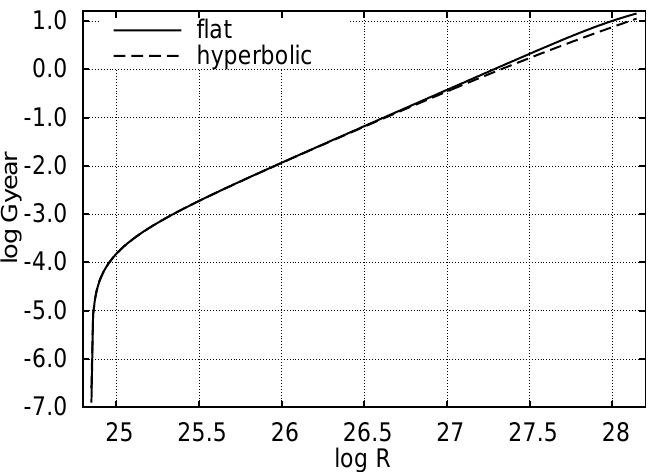
Fig. 2a. The age of the universe versus log R for the flat model universe with cosmo- logical constant (solid curve) and for a hyperbolic universe (dashed curve).